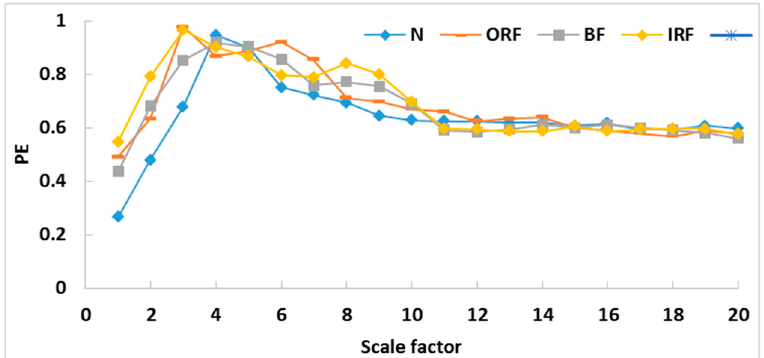
Figure 10. Multiscale permutation entropy ( MPE) of bearing signals for four health conditions with different scale factor.